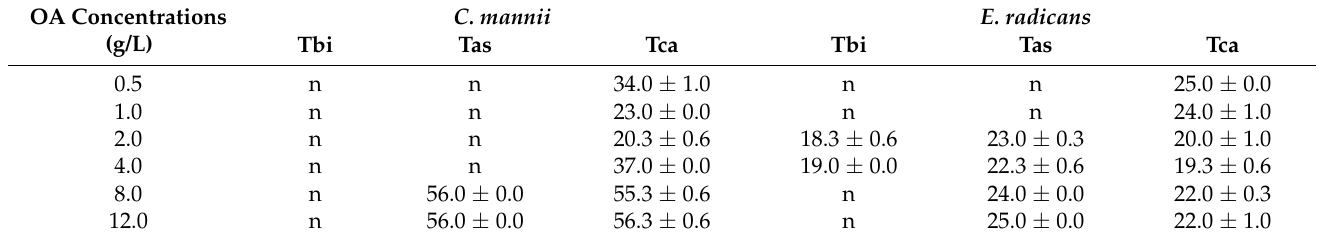
Table 2. The time of mycorrhizal fungi peloton formation was detected in orchid protocorms under different oatmeal agar (OA) concentrations (days ± s.d.).